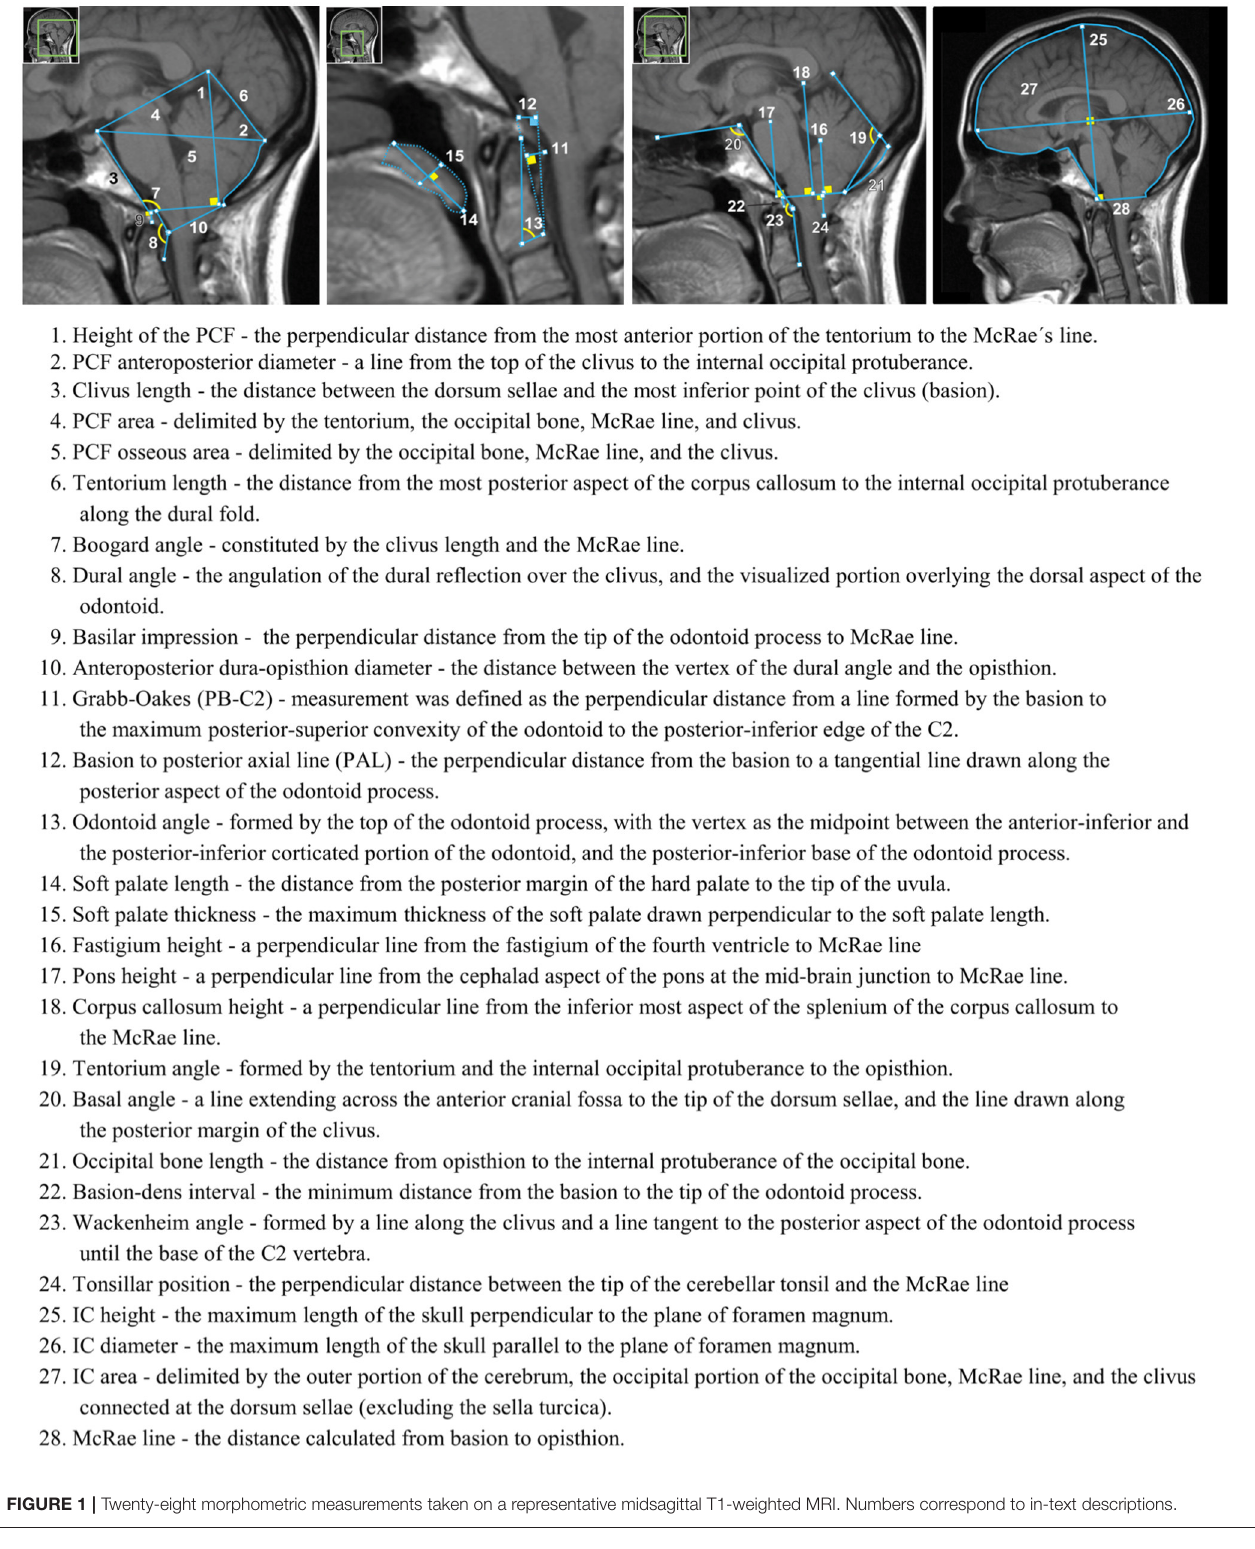
Frontiers in Neuroanatomy | www.frontiersin.org